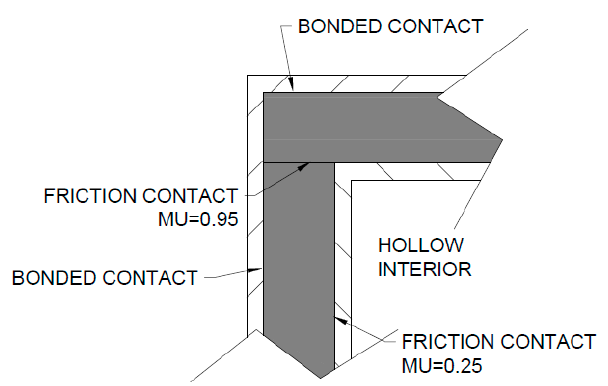
Figure 12. The contact conditions are shown on the upper-left portion of Figure 11, for the various components of the GRCCs